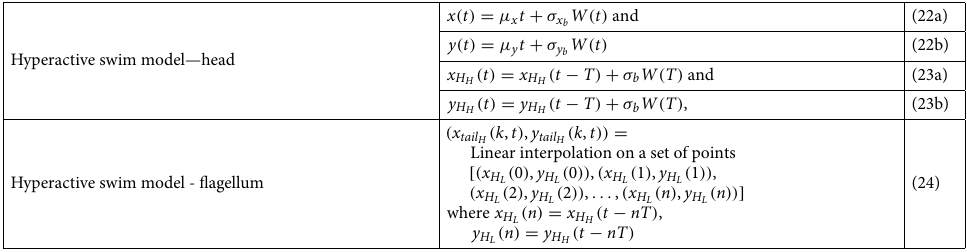
Table 3. Simulation of a hyperactive swimming cell. (µ x , µ y ) : drift coefficients of Brownian motion. , σ (σ x y b ) : diffusion coefficients of Brownian motion. W ( t ) : standard 1-dimensional Brownian motion b , y between each simulation frame. ( x Tail Tail H ) : a curve along the center of the flagellum of hyperactive cell. H